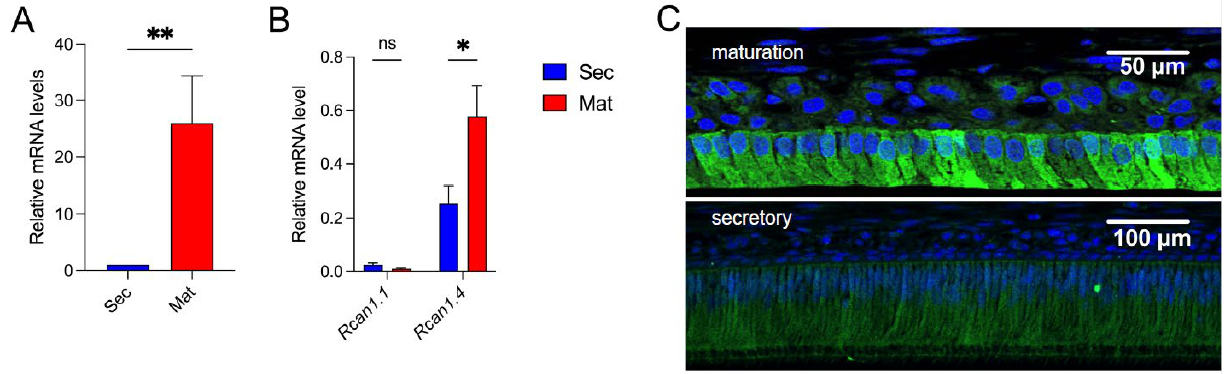
Figure 1. ( A ) Relative mRNA expression of Rcan1 in rat secretory- and maturation-stage ameloblasts. ( B ) Relative mRNA expression of the two RCAN1 isoforms ( Rcan1.1 , Rcan1.4 ) in rat secretory- and maturation-stage ameloblasts. ( C ) Immunofluorescent localization of Rcan1 (green) in maturation- and secretory-stage ameloblasts. Dapi = blue. Data represent the mean ± SEM of three independent experiments analyzed by Student’s t -test. * p < 0.05, ** p <